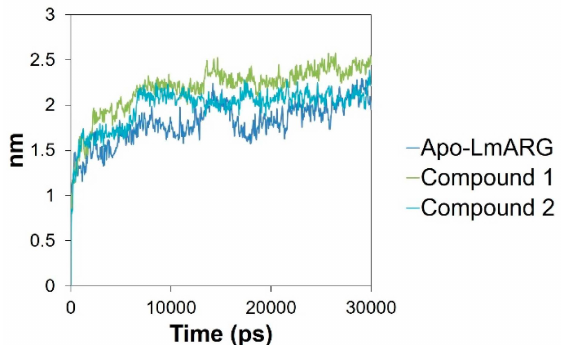
Figure 3. Root Mean Square Deviation analysis of C α in the Apo-LmARG and the respective